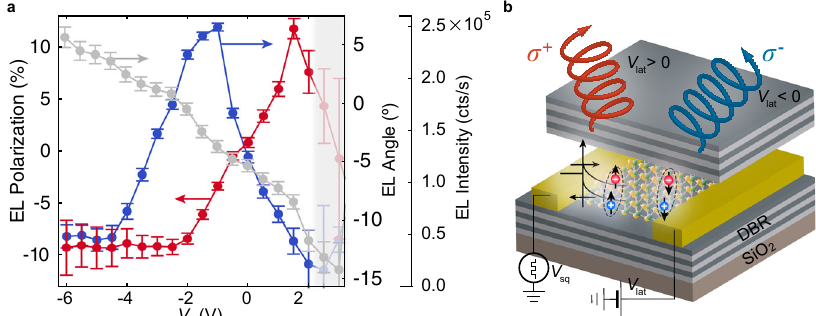
Fig. 5 | Device operation. a Weighted arithmetic mean of EL angle (gray), polar- ization(red)and integratedintensity(blue)extracted from the dispersionmapsin Fig.4.Errorbarsrepresentthestandarderror.Thegrayboxcoversthedatapoints